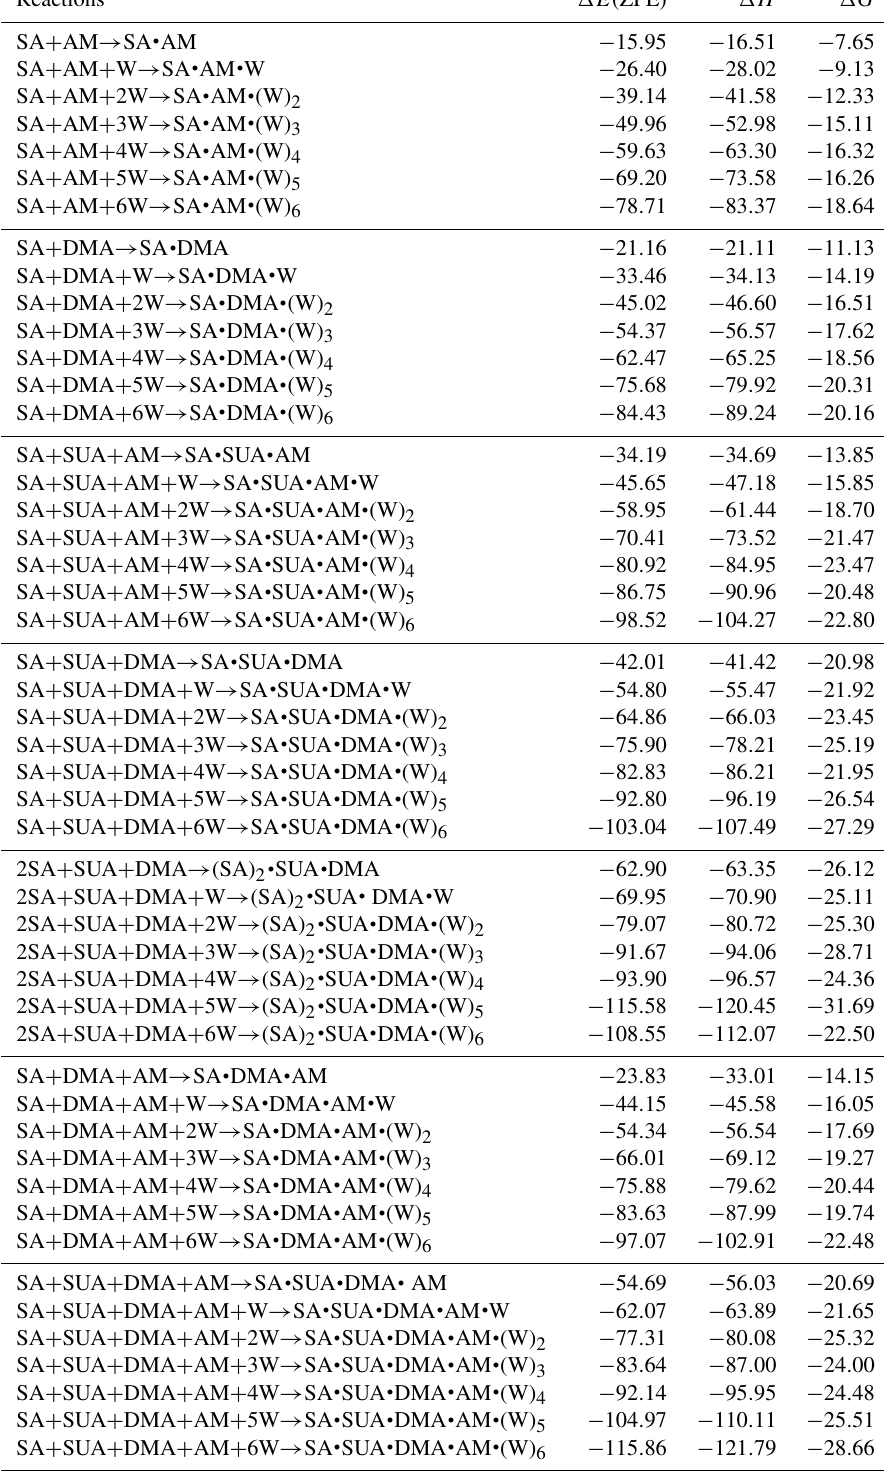
Table 2. Calculated binding energy (cid:49)E (ZPE), enthalpy (cid:49)H , and Gibbs free energy (cid:49)G (at T = 298 . 15K and p = 1atm) at the PW91PW91/6-311 ++ G(2d, 2p) level of theory for the hydrated clusters. Energies are in kilocalories per